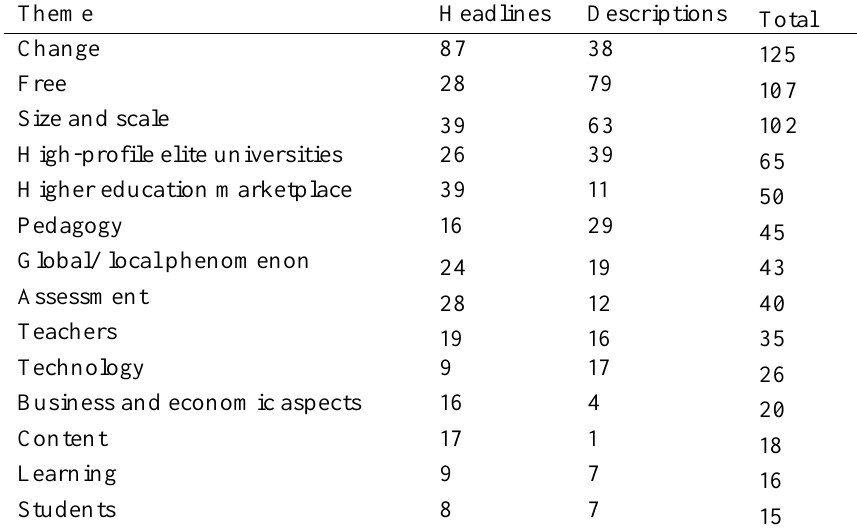
Issues and Meanings Associated with MOOCs within the Headlines and In-Text Descriptions of News Media